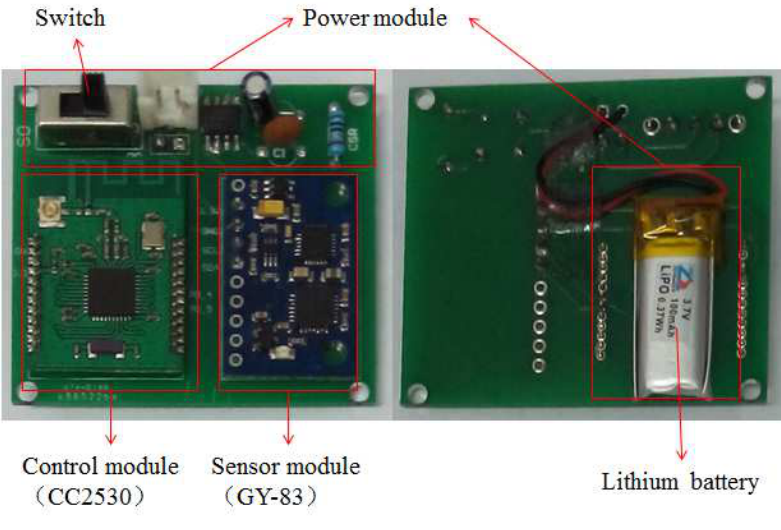
Figure 5. The designed sensor